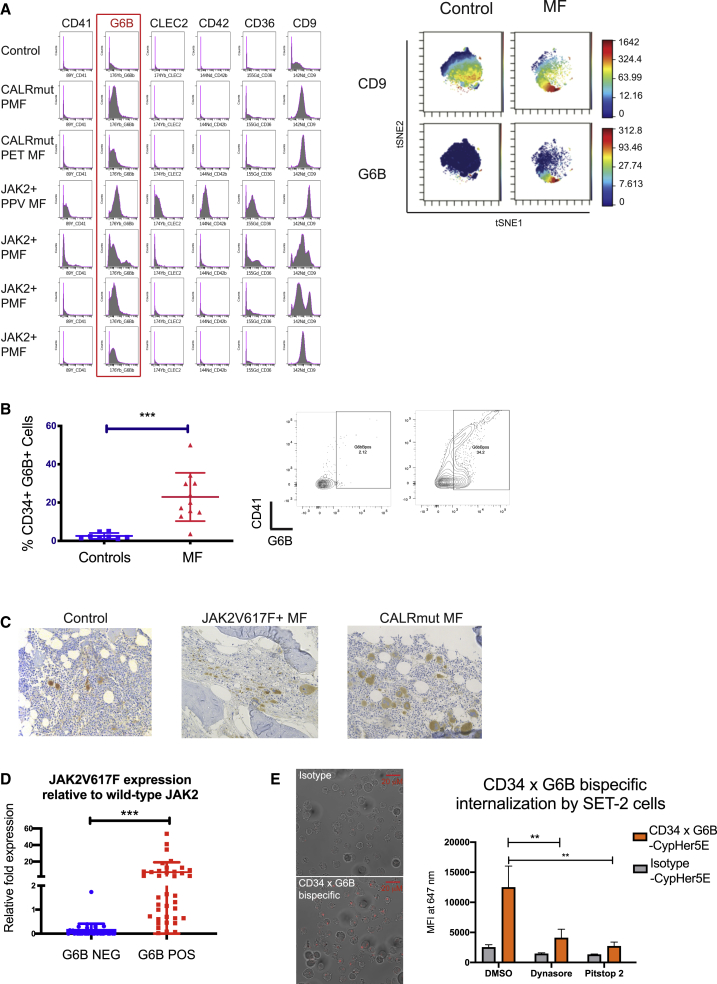
Expression of Cell Surface G6B, a Cell Surface Protein, Identifies Mutant Clone-Derived HSPCs in Myelofibrosis(A) Left: expression of 6 megakaryocyte markers from a panel of 20 HSPC and megakaryocyte cell surface antigens assayed by mass spectrometry time of flight (CyTOF) shows expression of G6B on CD34+ HSPCs from patients with primary myelofibrosis (PMF), post-essential thrombocythemia myelofibrosis (PET-MF), and post-polycythaemia vera myelofibrosis (PPV-MF) with either JAK2V617F (JAK2+) or calreticulin (mutCALR) driver mutations. Histograms show cell count (y axis) by expression level (x axis). Right: viSNE dimensionality reduction plots on a representative control and myelofibrosis sample for CD9 and G6B, illustrating more substantial differential expression of G6B than CD9 in myelofibrosis versus control cells(B) Flow cytometric analysis of G6B expression on CD34+ Lin− HSPCs showing significant increase in G6B+ cells in myelofibrosis (% GFP+ cells, 28.8% ± 5.5% versus 2.4% ± 1.0%); chart shows mean + SEM (left) and example plot (right) shown, illustrating expression in both CD41+ and negative cells. ∗∗p ≤ 0.01 (t test). Controls (N = 8); myelofibrosis (N = 11).(C) Immunohistochemical staining for G6B (diaminobenzidine, DAB brown) of bone marrow biopsy sections from controls and myelofibrosis patients with JAK2V617F and mutCALR-positive myelofibrosis showing marked expansion of G6B+ megakaryocytes and progenitors in myelofibrosis.(D) Mononuclear cells from healthy donors and patients with JAK2V617F+ myelofibrosis were combined and 50 cell “mini-bulk” replicates were sorted from the G6B+ and G6B− fractions for Taqman qRT-PCR to quantify expression of JAK2V617F mutated and wild-type JAK2. Chart shows JAK2V617F relative to wild-type JAK2 expression for all mini-bulks from 3 replicate experiments.(E) Internalization of a CD34 × G6B bi-specific antibody and isotype control antibody conjugated to a pH-sensitive cyanine CypHer5E dye that fluoresces at an acidic pH following internalization. Left: representative images show clear intracellular fluorescence for CD34 × G6B bi-specific but not isotype control. Right: mean fluorescence intensity of cells measured by flow cytometry 30 min after addition of antibody with/without two endocytosis inhibitors, Dynasore and Pitstop 2. Data shown using SET-2 cells, chart shows mean + SEM, ** - P < 0.01 n= 3. See also Figure S7.